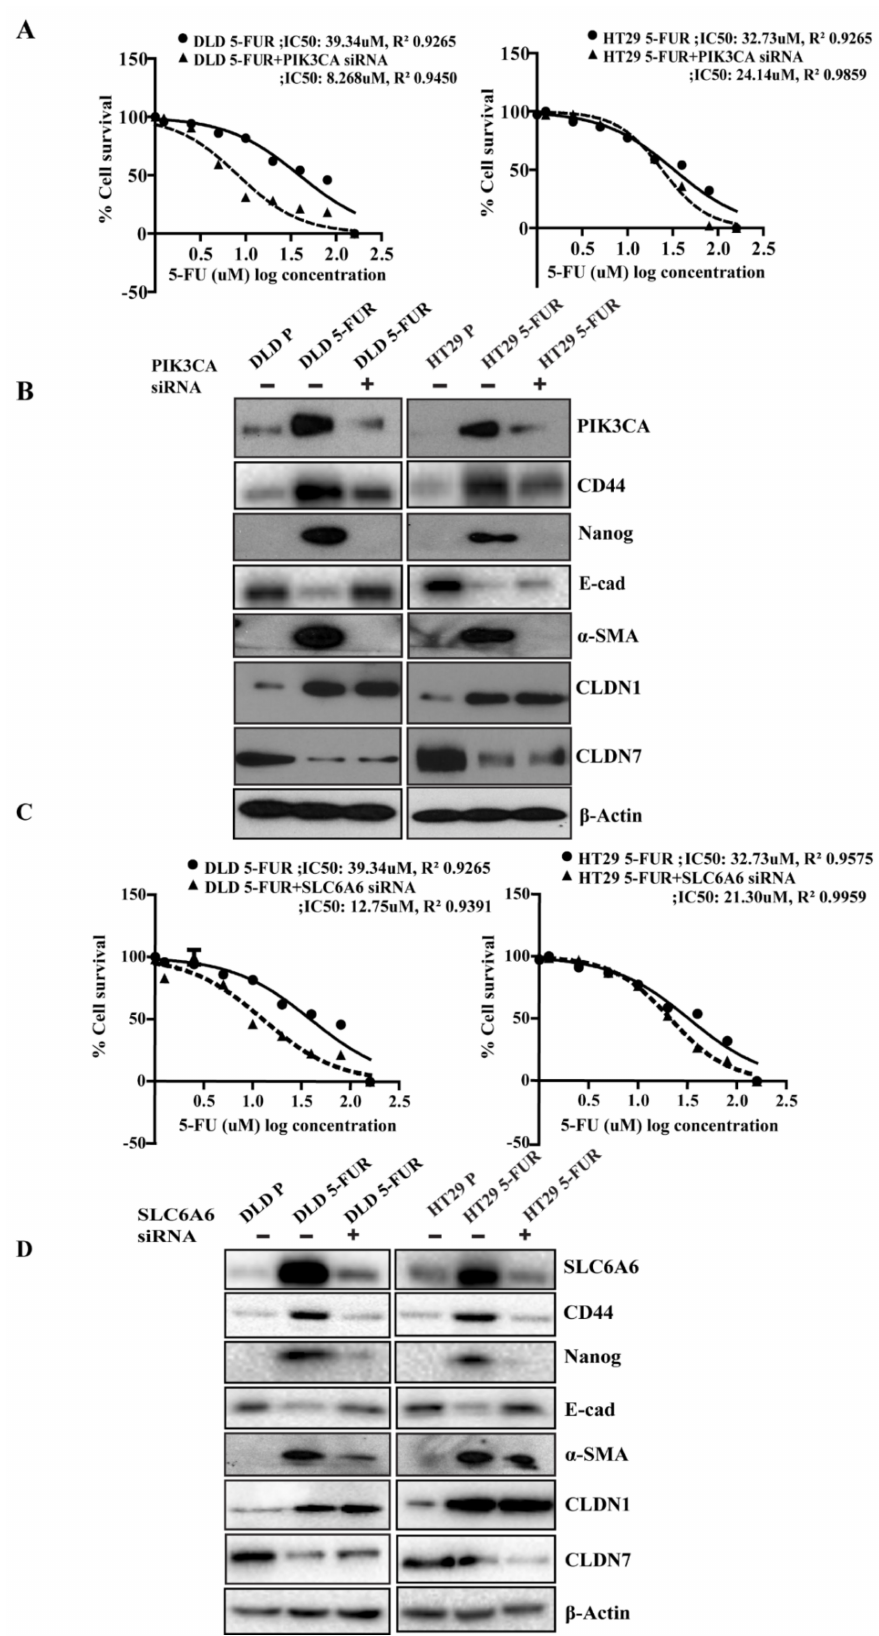
Figure 7. PIK3CA and SLC6A6 silencing decreases resistance to 5-FU in 5-FUR cells: ( A ) The DLD 5-FUR/PIK3CA silenced 5-FUR cells and HT29 5-FUR/PIK3CA silenced 5-FUR cells were treated with the range of 5-FU doses (160 µ M to 0.0125 µ